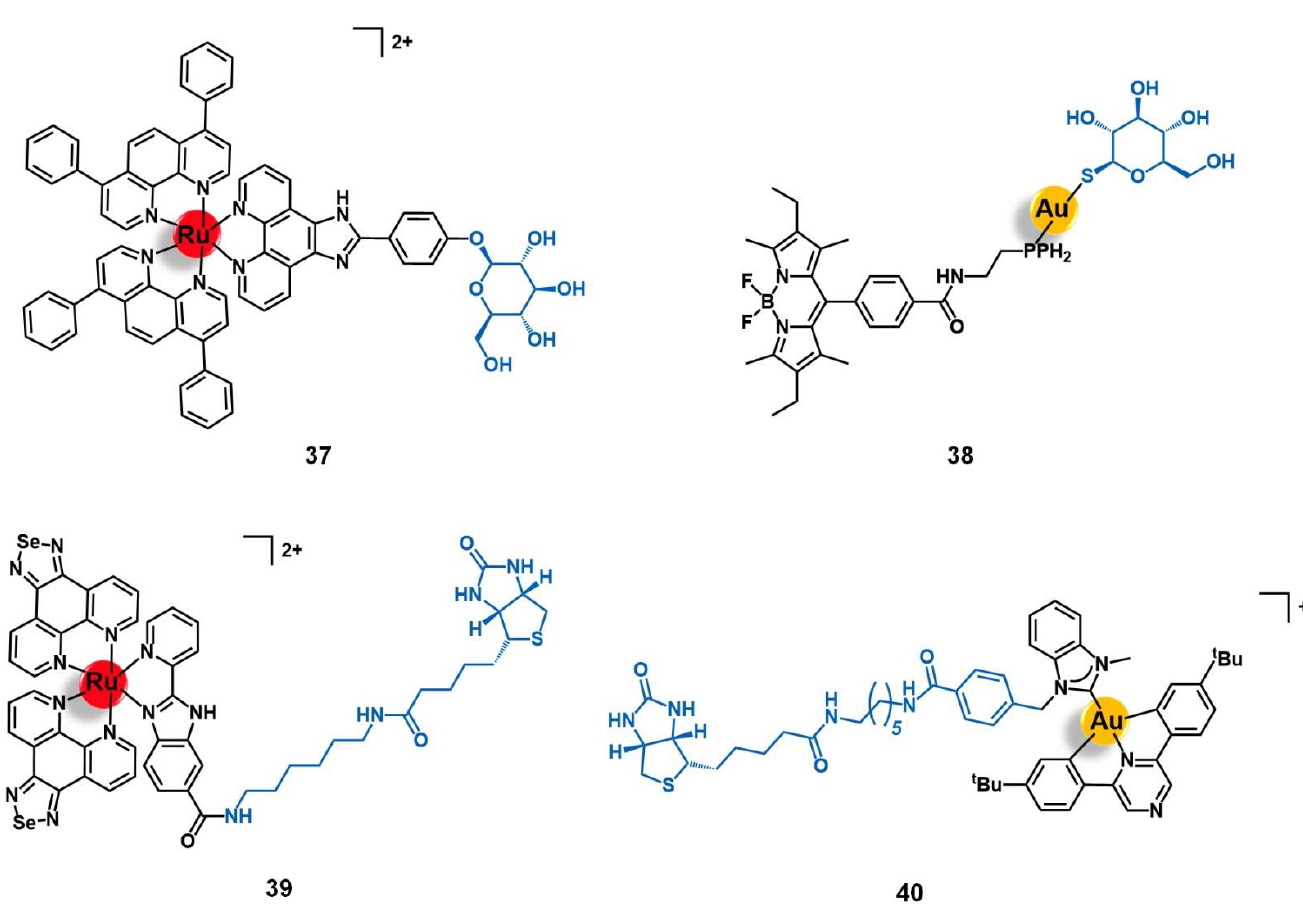
Figure 13. Ru(II), Au(I) and Au(III) conjugates that target the glucose receptors ( 37 and 38 ) or the biotin receptors ( 39 and 40 ).